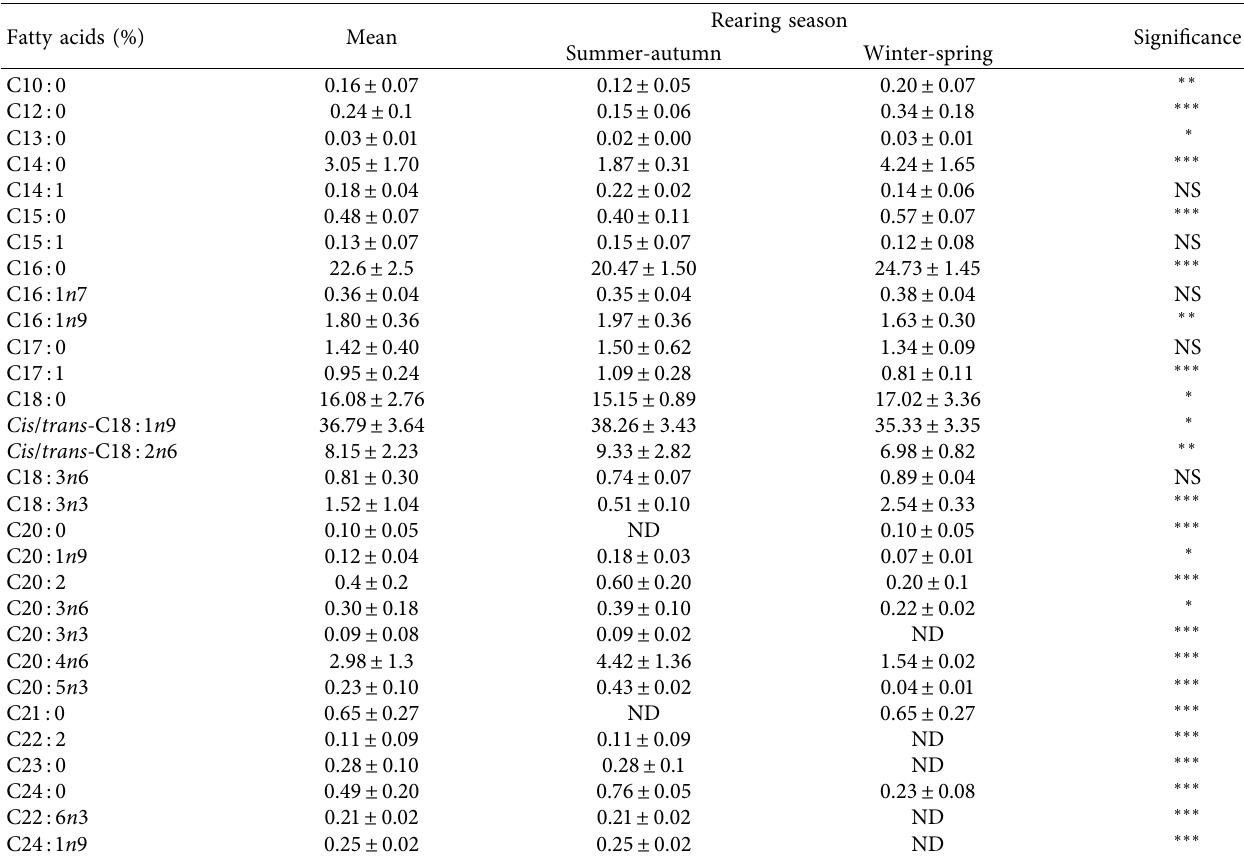
Table 2: Rearing season effect on the fatty acids profile of Beni-Guil sheep